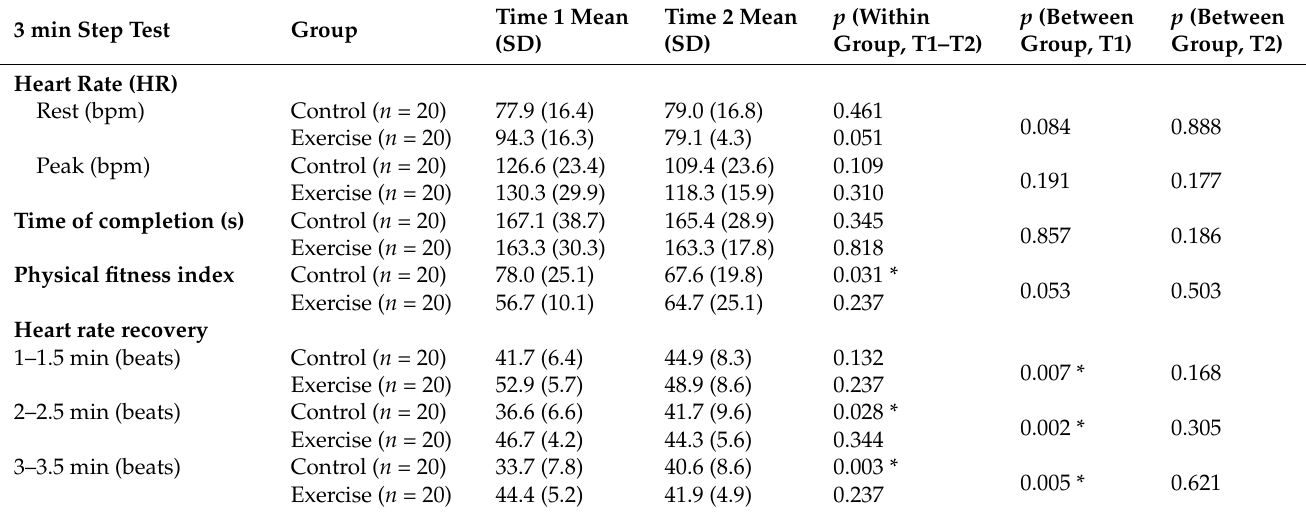
Table 4. Cardiovascular fitness and heart rate recovery between the exercise group and the control group at pretest and